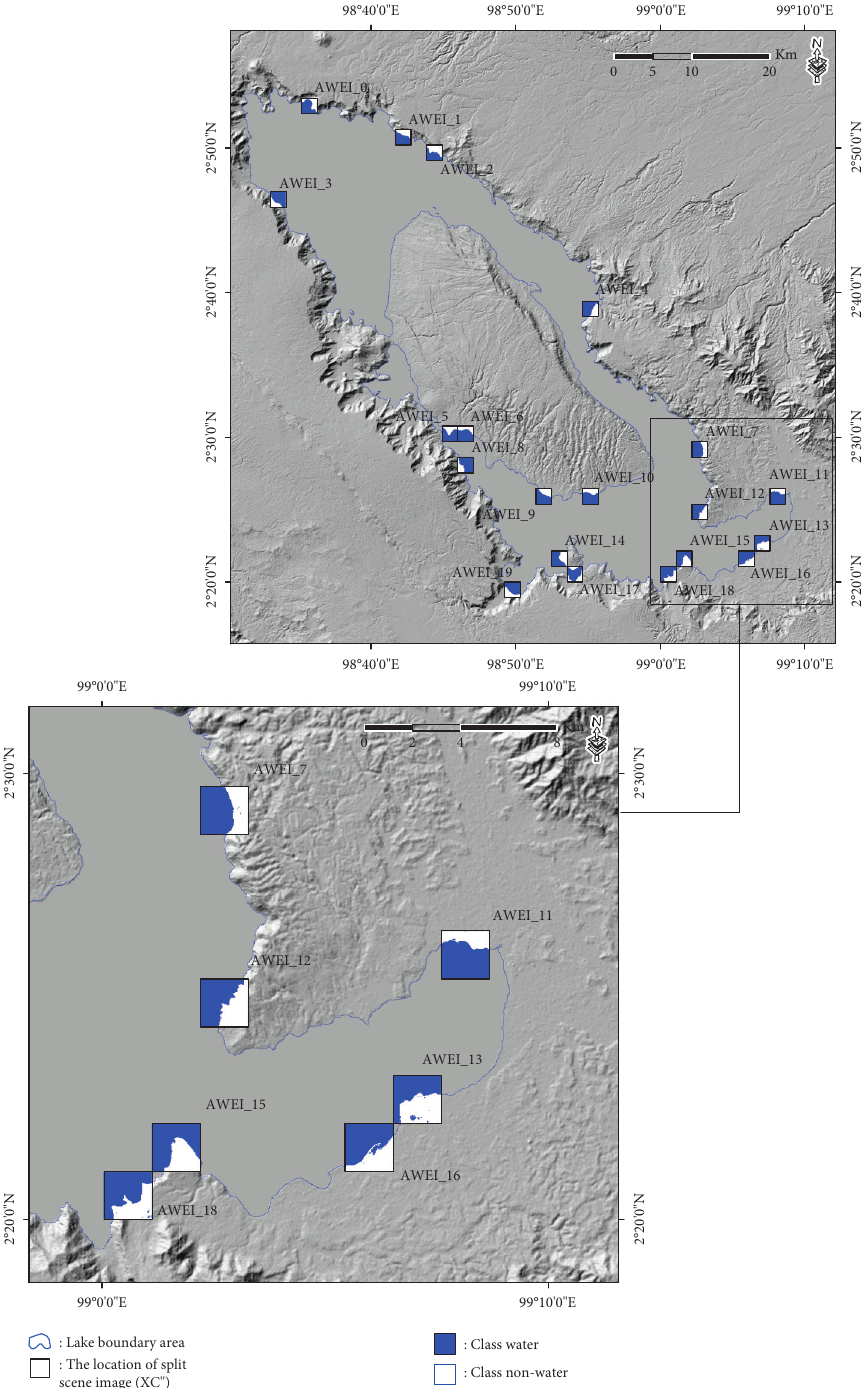
Figure 9: Location of the split scene image selection in the scene data ( XC ″ ) of the subscene images ( XCi ″ ) with a size of 2km × 2km based on the natural break threshold